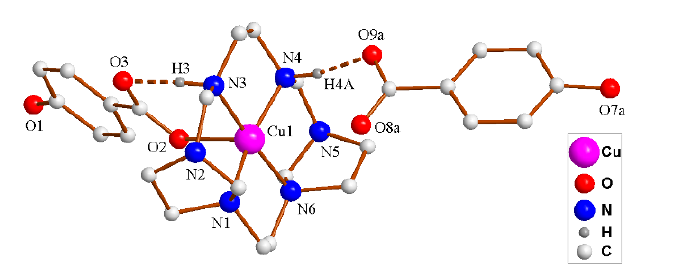
Figure 2. View of the interactions, including hydrogen bonding, between a complex cation [Cu(CHA)] 2+ and carboxylate groups of TCM 4- tetraanions in the crystal of 3 •11H O. Symmetry equivalent atoms (0.5+x, 1.5–y, 0.5+z) are given by 2